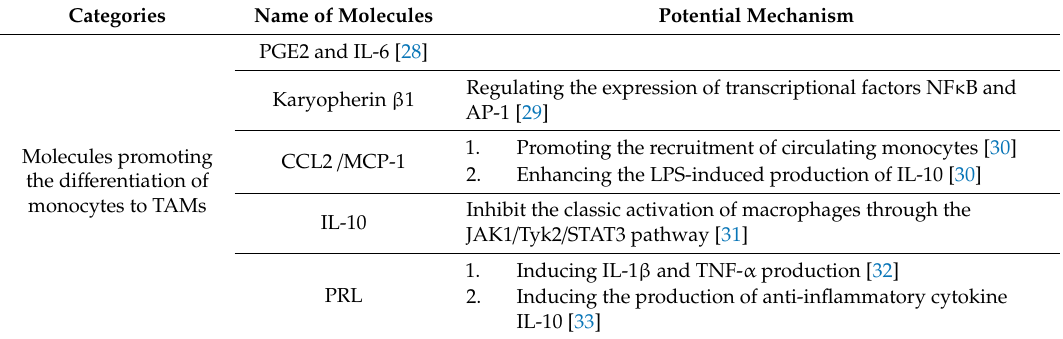
Table 2. Tumor-derived molecules acting in tumor-associated macrophage (TAM) formation in cervical cancer